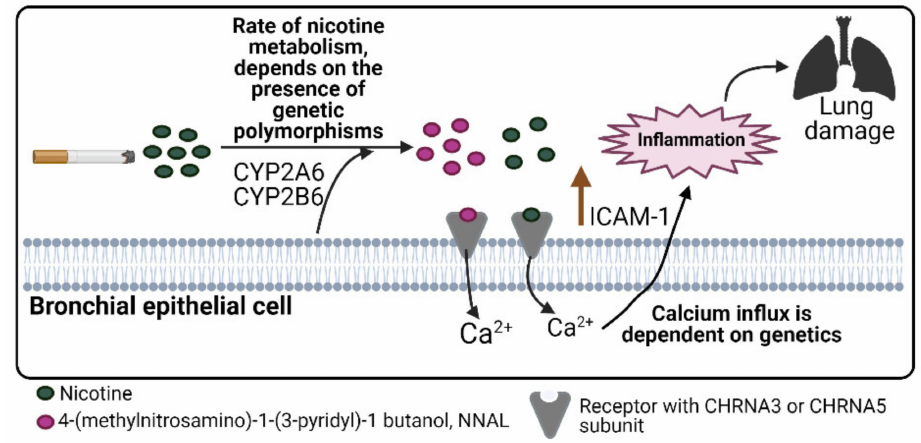
Figure 3. Participation of CYP2A6, CYP2B6, CHRNA3 and CHRNA5 in COPD. Created